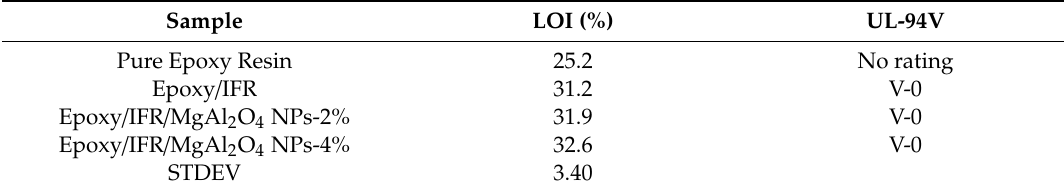
Table 2. Limiting oxygen index (LOI) and a vertical burning test (UL-94V) results of the